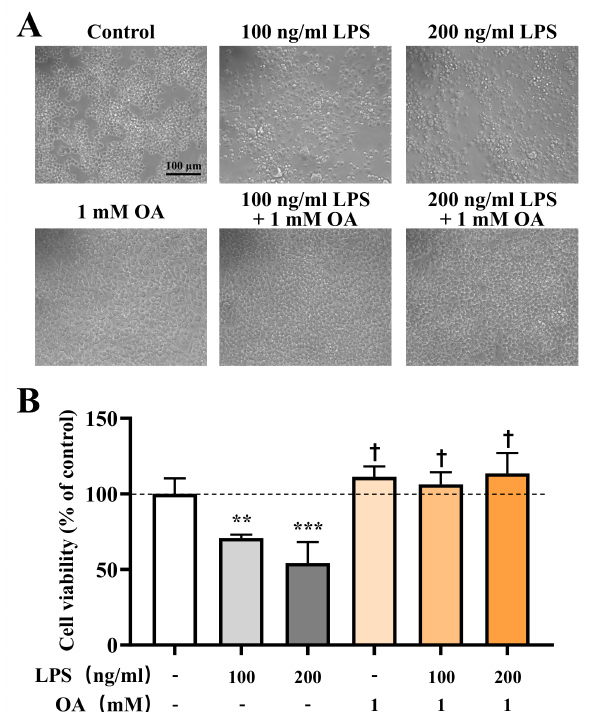
Figure 1. OA induces loss of Raw264.7 cells. (A) Representative images of cells under different treatments. Scale bar, 100 μm. (B) Summary of cell viability after 24 h treatment of various conditions. ** and *** represented significant different from the control with a p < 0.01 and 0.001, respectively. † represented no significant difference comparing with the control. The dashed line indicated 100%